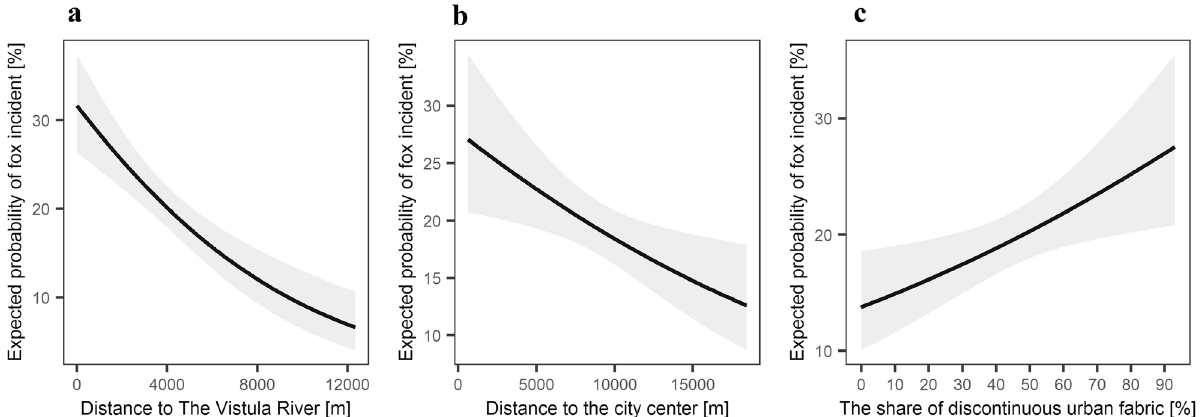
Figure 8. Probability of the red fox incident as based on the reports (1998–2015), delivered by the Municipal Forests—Warsaw, in relation to distance to ( a ) the Vistula river, ( b ) the city centre and ( c ) share of discontinuous urban fabric within 1500 m radius around location of red fox incident. Explanatory variables that were significant in the logistic regression model (see Table 2) are